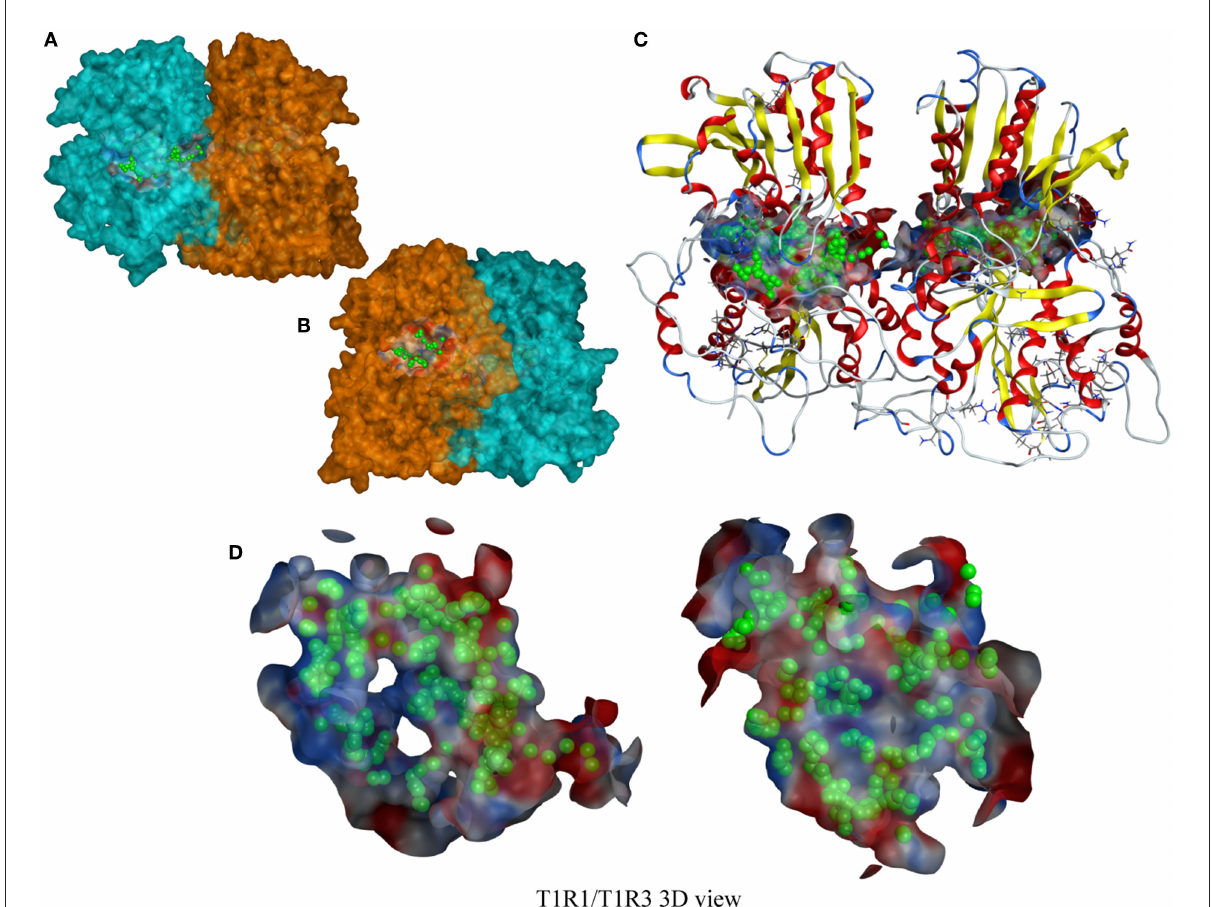
FIGURE4 A T1R1/T1R3 3D view. (A,B) a T1R1/T1R3 molecular surfaces view, the blue part is T1R1, the orange part is T1R3; (C) a T1R1/T1R3 ribbon-style view, including a docking cavity and binding amino acid sites (the green sphere); (D) a docking cavity and binding amino acid sites in T1R1/T1R3